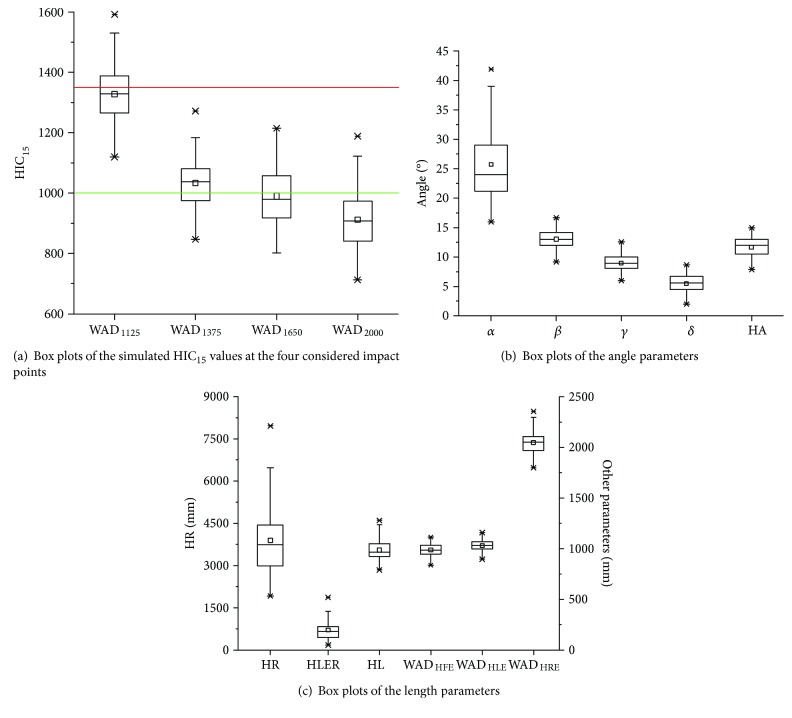
Box plots of the simulated HIC15 at the four impact points and the styling feature parameters.